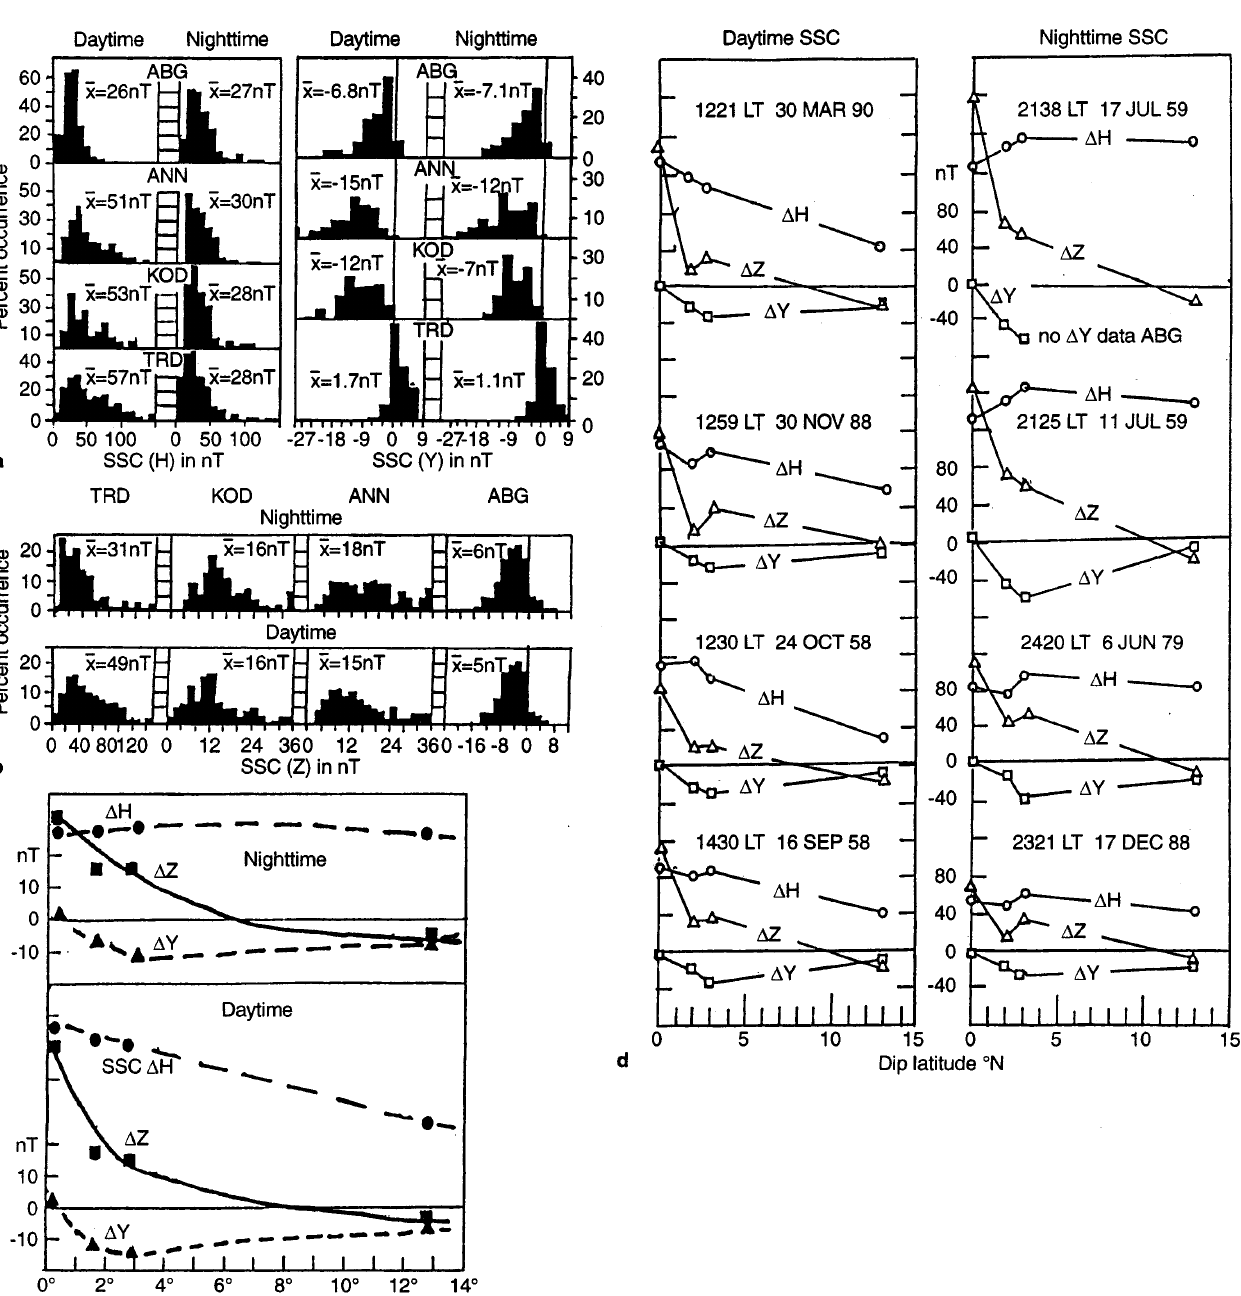
Fig. 3a–d. Histograms of the amplitudes of sudden commencements in a horizontal field H and Y and b vertical field, Z occurring during